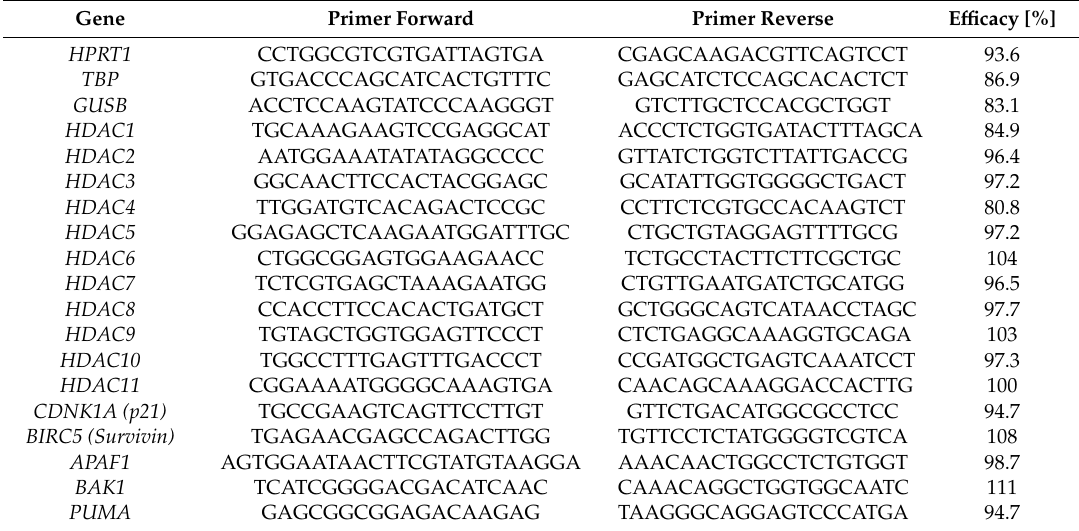
Table 8. Primer sequences for